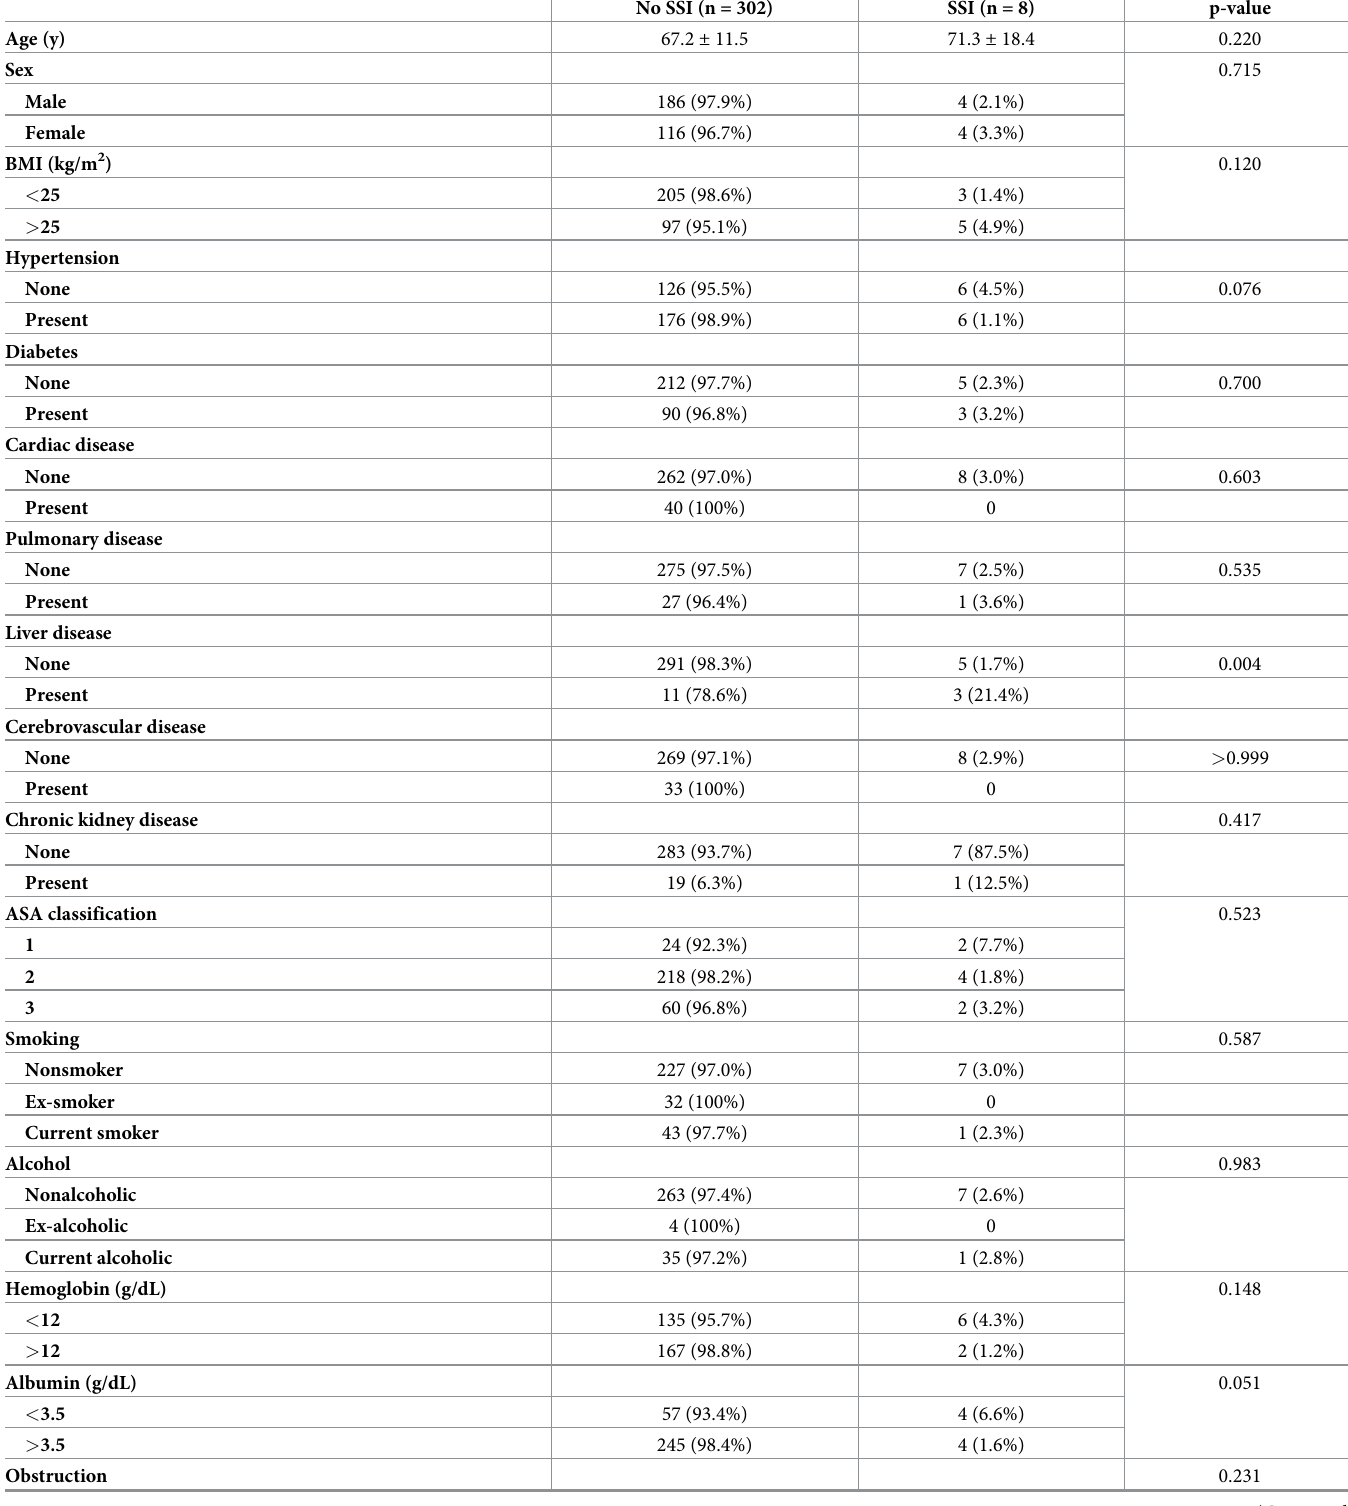
Table 3. Univariable analysis for factors that affect surgical site infection in the overall cohort (n =